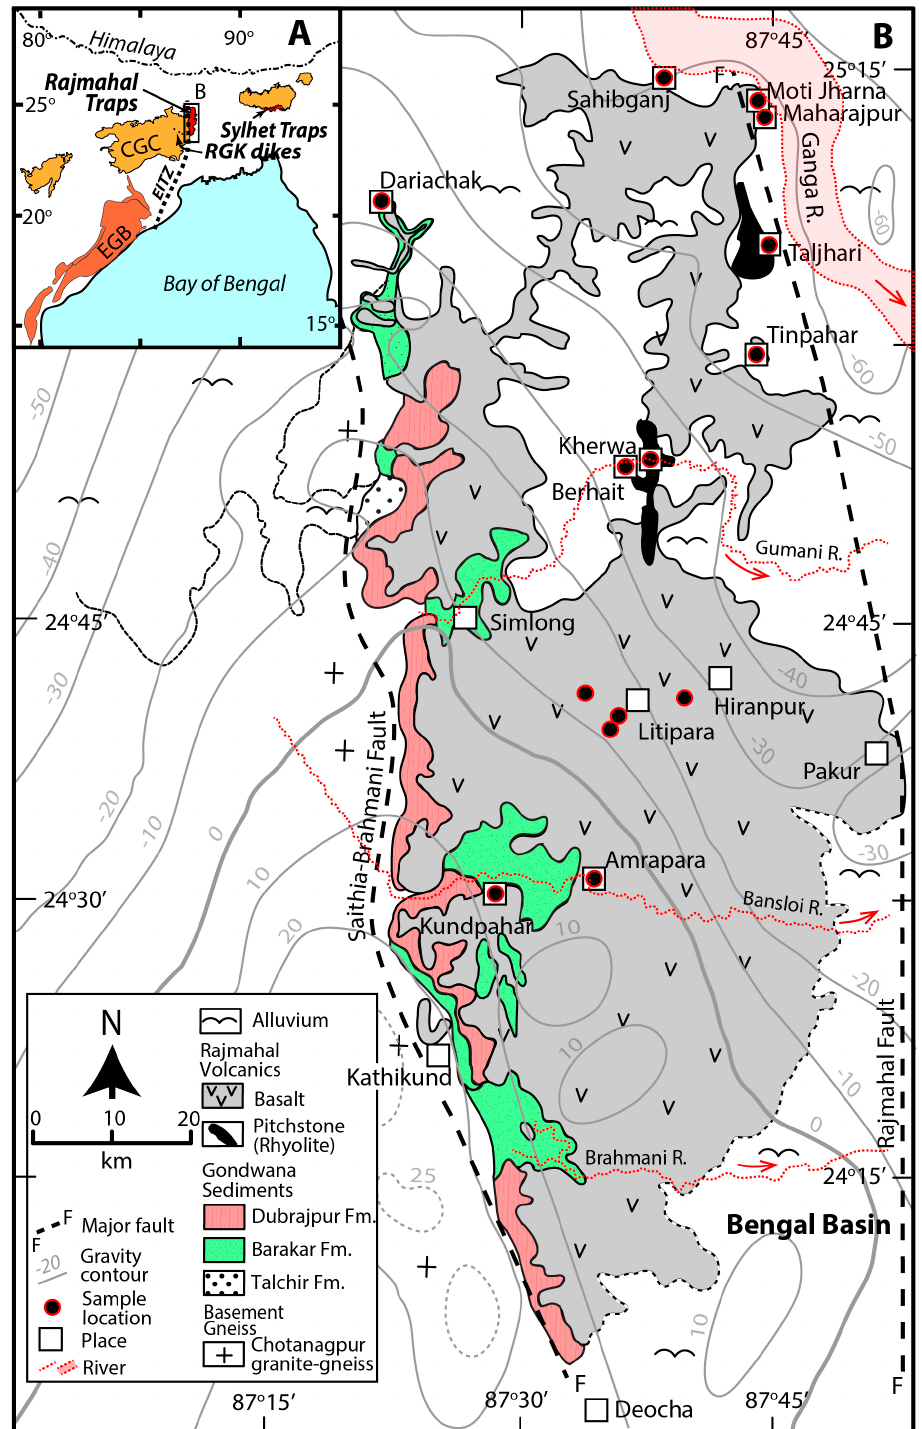
Figure 2. ( A ) Location of the Rajmahal Traps, Sylhet Traps, and Raniganj – Giridih – Koderma (RGK) dikes on the Indian Shield. CGC — Chotanagpur Gneiss Complex, EGB — Eastern Ghats belt, EITZ — Eastern Indian Tectonic Zone. ( B ) Detailed geological map of the Rajmahal Traps (after [32]). The Bouguer gravity contours ( − 60 to +25 mGal) are after [36].